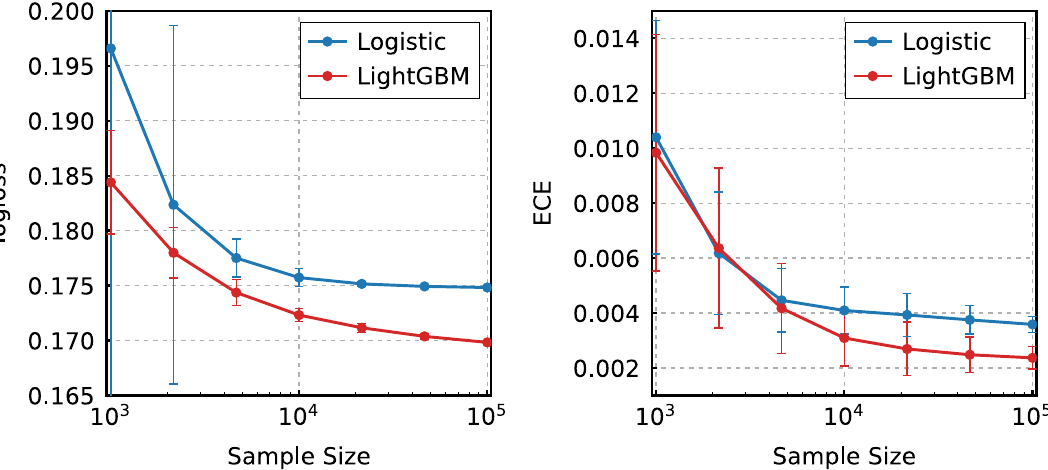
Figure 3. Model performances of the LR and LightGBM models with various sample sizes. The figure on the left shows the Logloss values as functions of the sample size, and the figure on the right shows the ECE values. The error bars are the standard deviation of 100 trials.